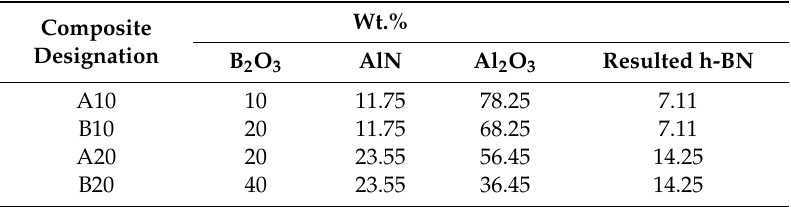
Table 1. Compositions of composites with varying amounts of B 2 O 3 and AlN that resulted in hexa-boron nitride (h-BN)